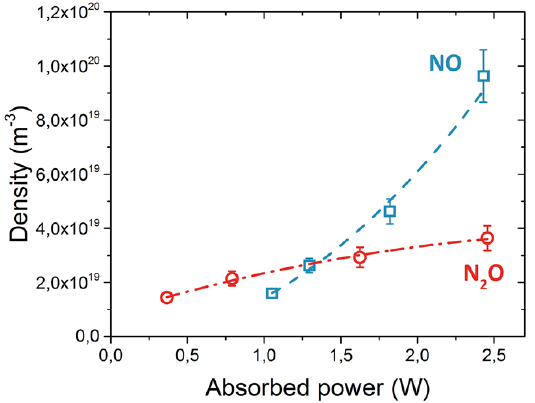
Figure 20. Absolute concentration of NO (blue square) and N 2 O ( red circle) produced by the micro plasma jet as a function of the absorbed power for a helium flow of 1.4 slm with constant 1400 ppm O 2 and 7100 ppm N 2 admixture. The dashed blue line and the dashed dot red line are the polynomial fit of NO and N 2 O densities, respectively [65], © IOP Publishing. Reproduced with permission. All rights reserved.